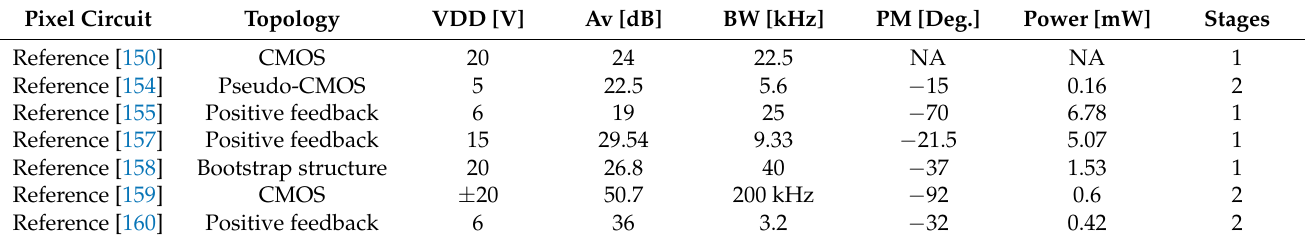
Table 3. Summarized performances for the representative amplifier of oxide-based